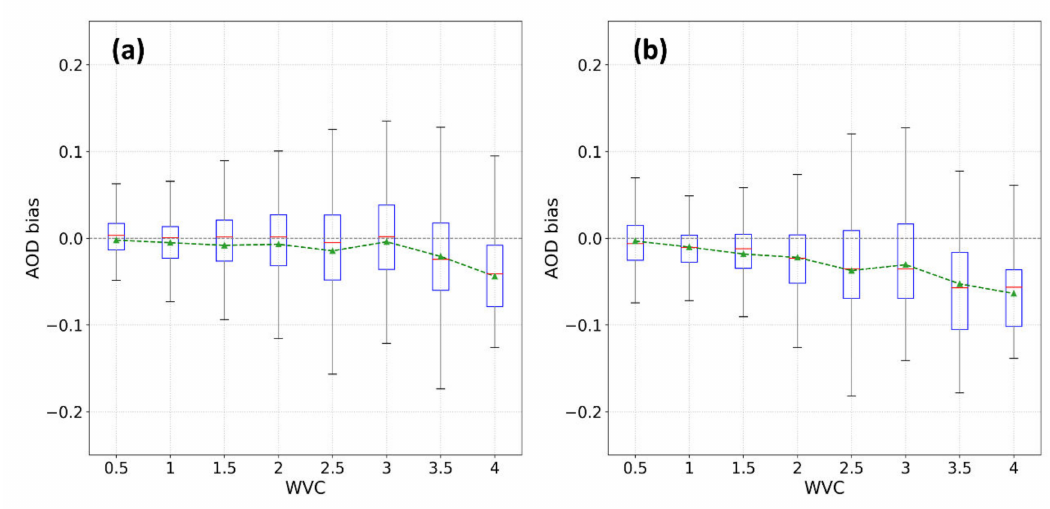
Figure 6. Same as Figure 4, but as a function of AERONET water vapor values. Box plots of AOD bias (in grey) for ERF-estimated AOD ( a ) and MODIS AODs ( b